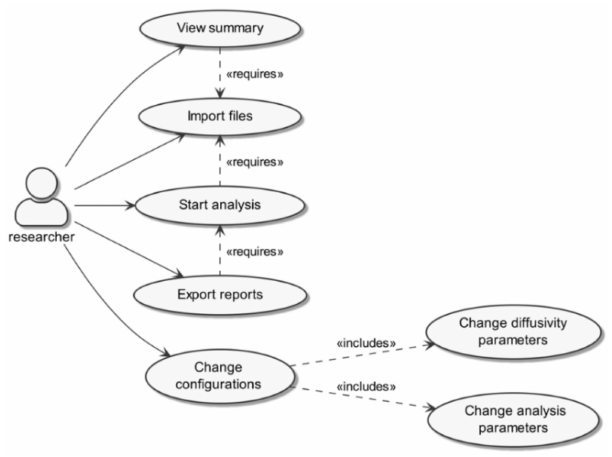
Figure 1. MPTHub Use Case